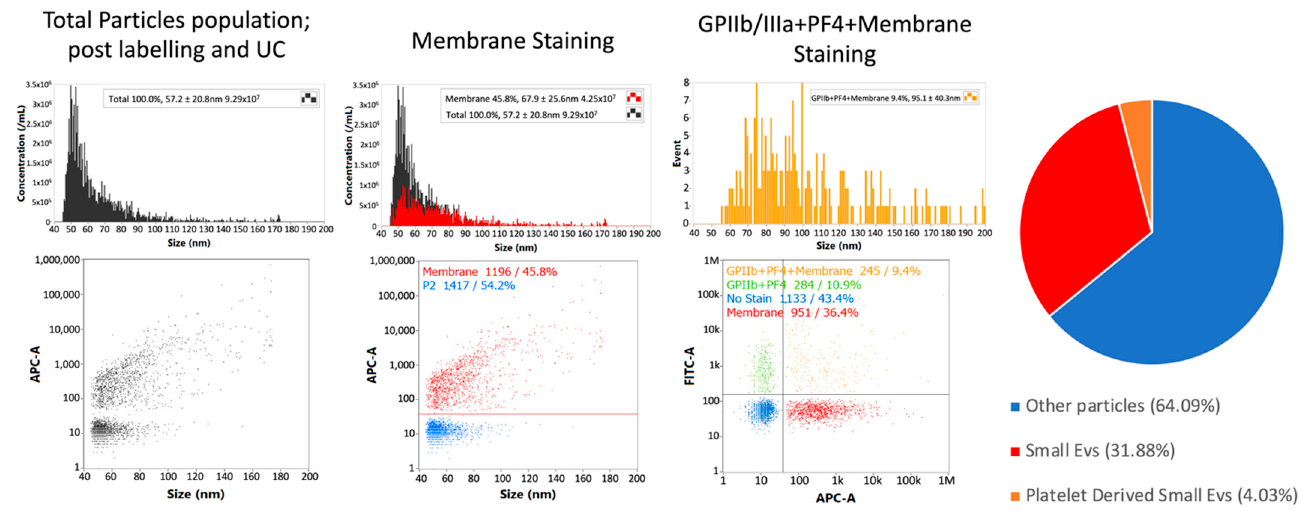
Figure 3. Single-particle phenotyping of ascites-derived small EVs by nFCM analysis (NanoFCM). Samples were fluorescently labelled with FITC-conjugated antibodies specific to GPIIb/IIIa and PF4 (FITC-A channel). In addition, the dye CellMask™ deep red plasma membrane stain (CM) was used (APC-A channel). Bivariate dot-plots of indicated fluorescence versus SSC are shown. The pie chart shows the average composition of all the samples analysed from the patient cohort. All percentages shown on images are for a single data point. Values from pie chart are true corrected values for all data. nFCM: nano-flow cytometry.